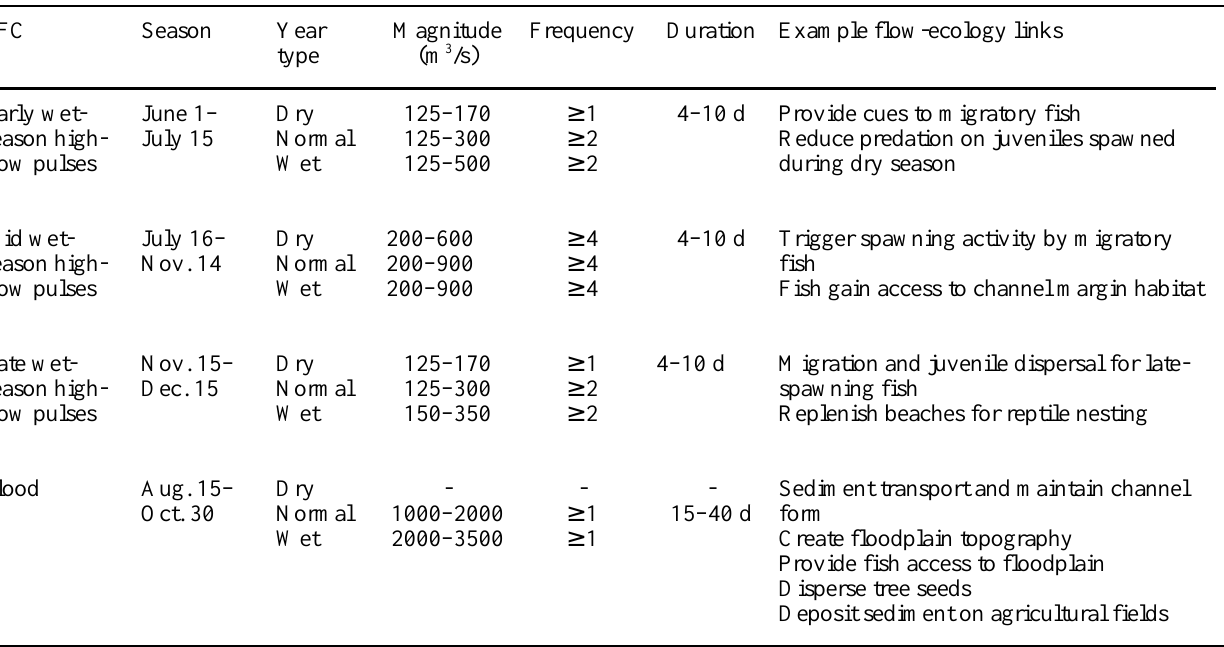
Table 1. Unified flow recommendation’s high-flow pulses and floods for dry, normal, and wet years. EFC = environmental flow